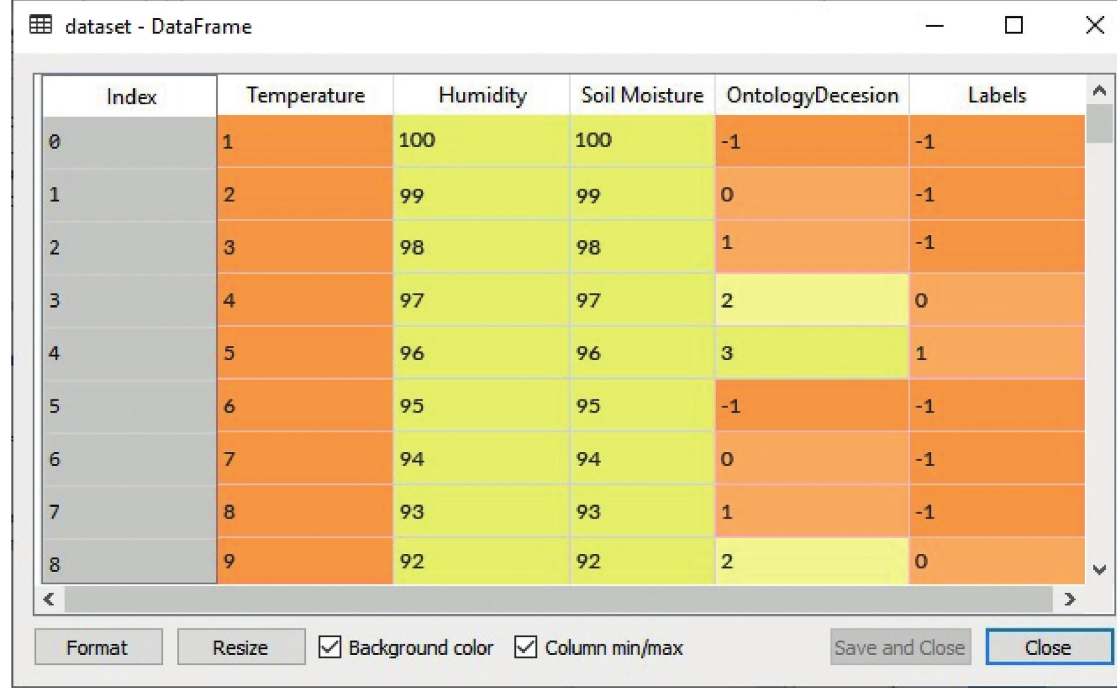
Figure 7: Sampled training Table 3: Working rules for different crops.